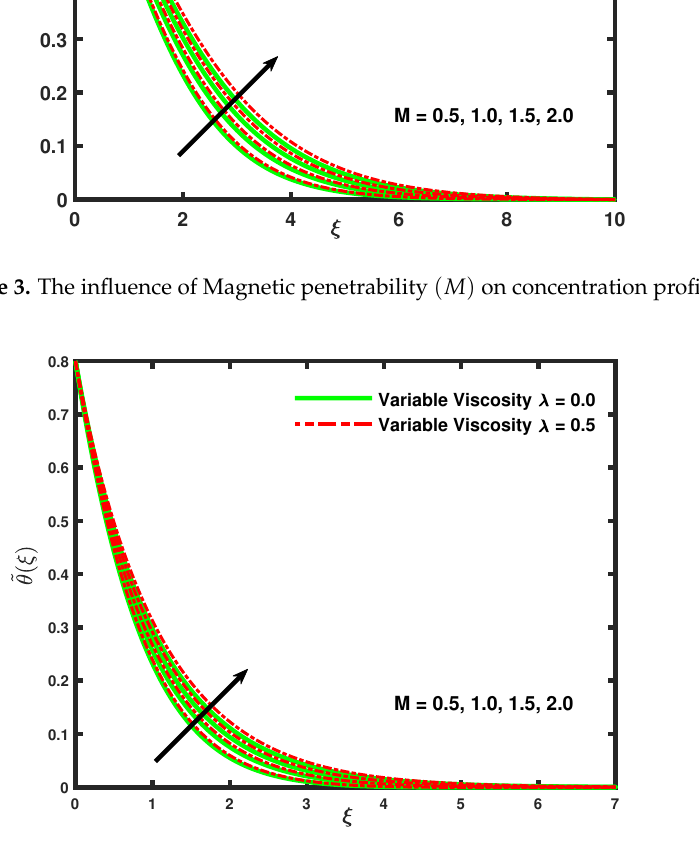
Figure 4. The influence of Magnetic penetrability ( M ) on Temperature